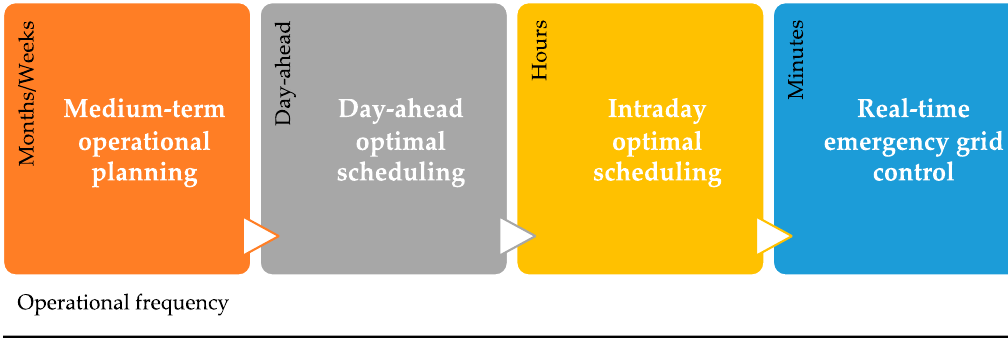
Figure 2. Schematic representation of the main objectives of smart charging strategies.